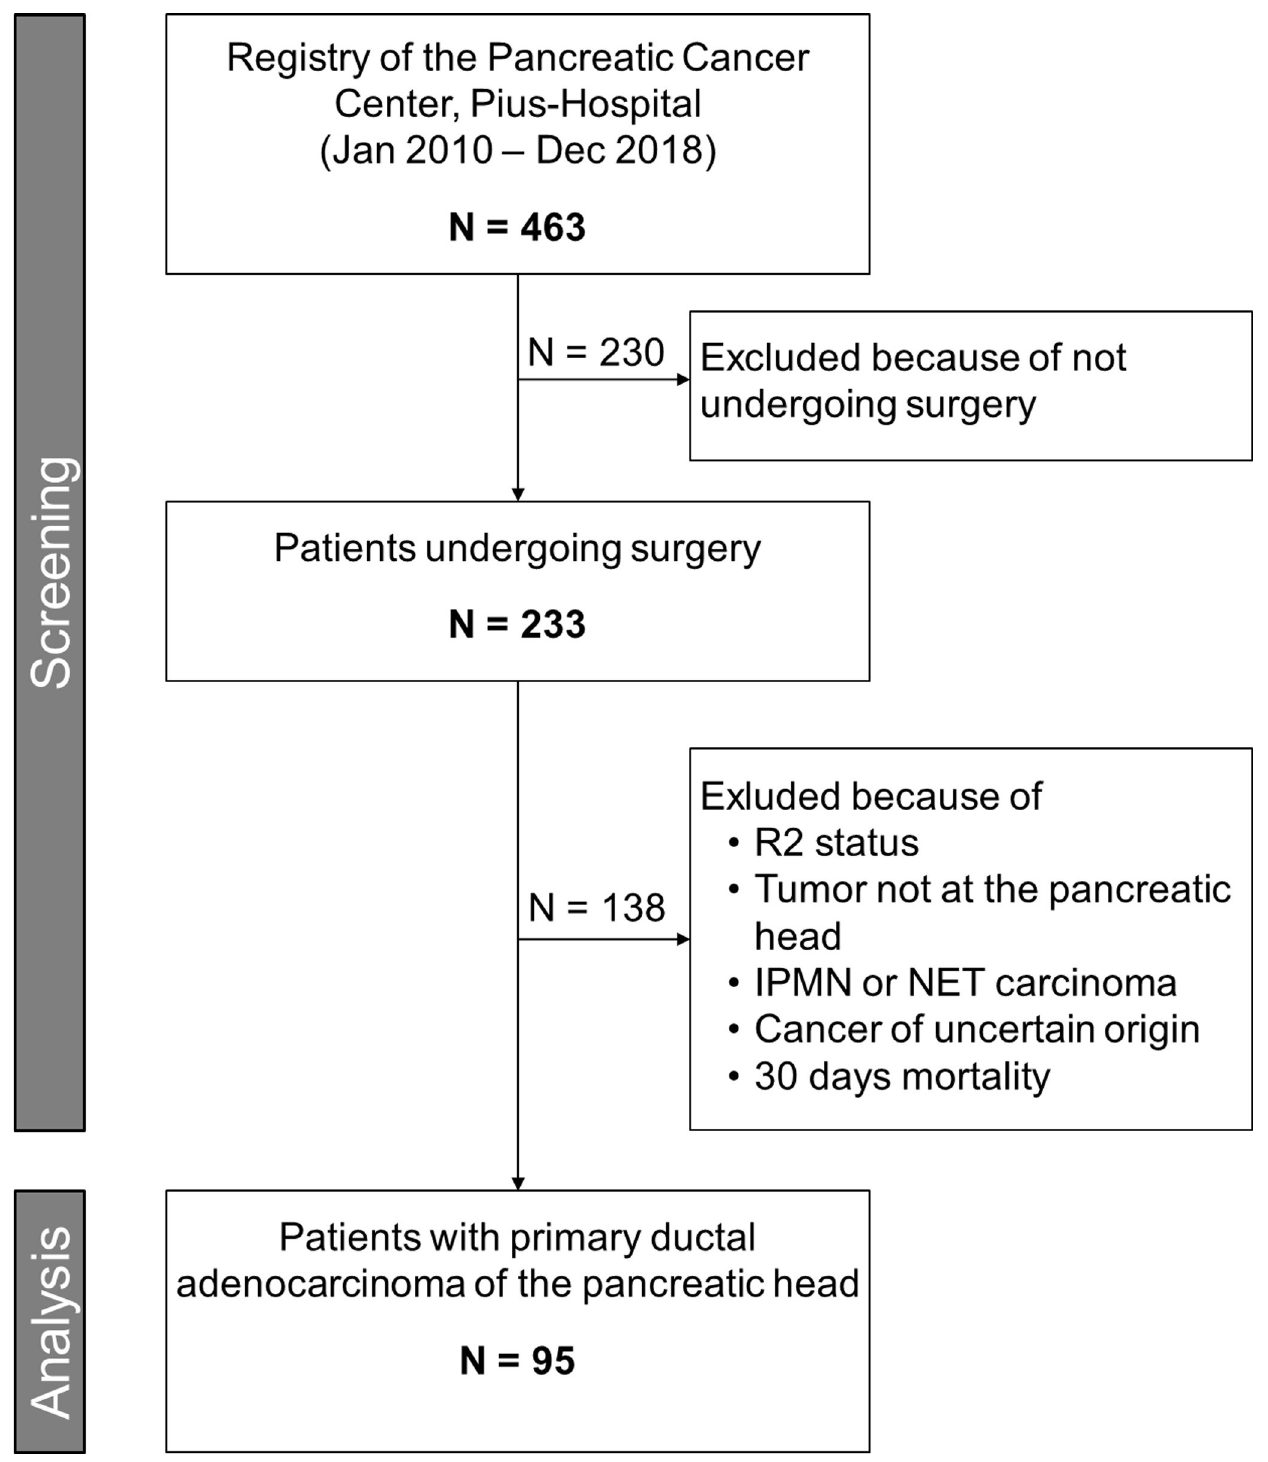
Fig 1. Study flow chart.